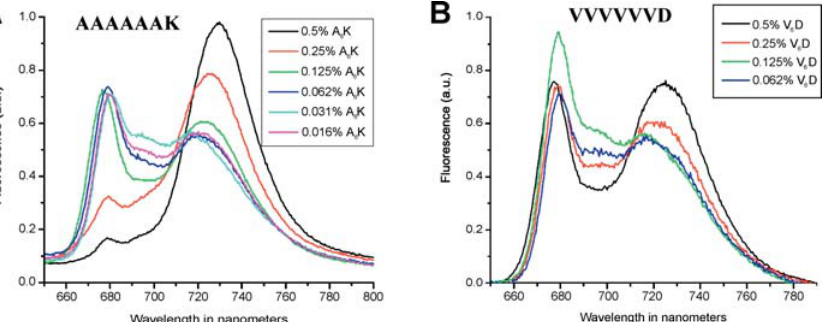
Figure 3. Emission Spectra of the Dried PS-I Complex Containing Various Concentrations of the Peptide Detergents A 6 K and V 6 D (A) A 6 K showed significantly enhanced ability to stabilize PS-I at a concentration of 0.5% (w/v) and showed reduced ability to stabilize PS-I complex at decreasing concentration. (B) V 6 D showed lesser ability to stabilize PS-I complex at the same concentration. DOI: 10.1371/journal.pbio.0030230.g003